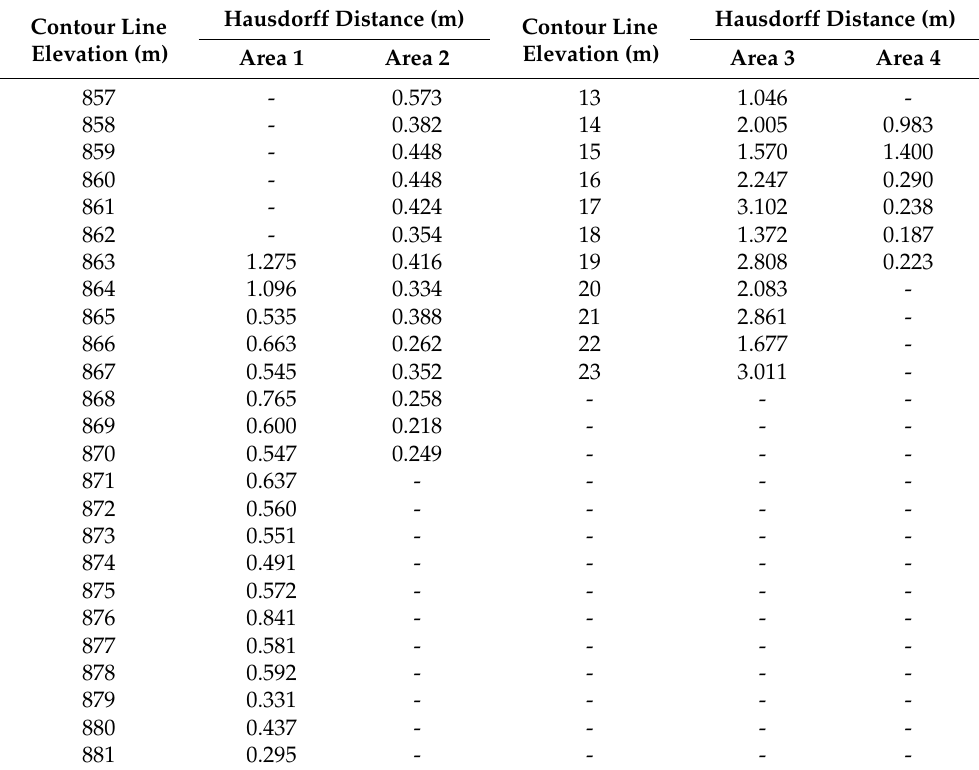
Table 6. Determination of dH for contour lines in areas 1 to 4.